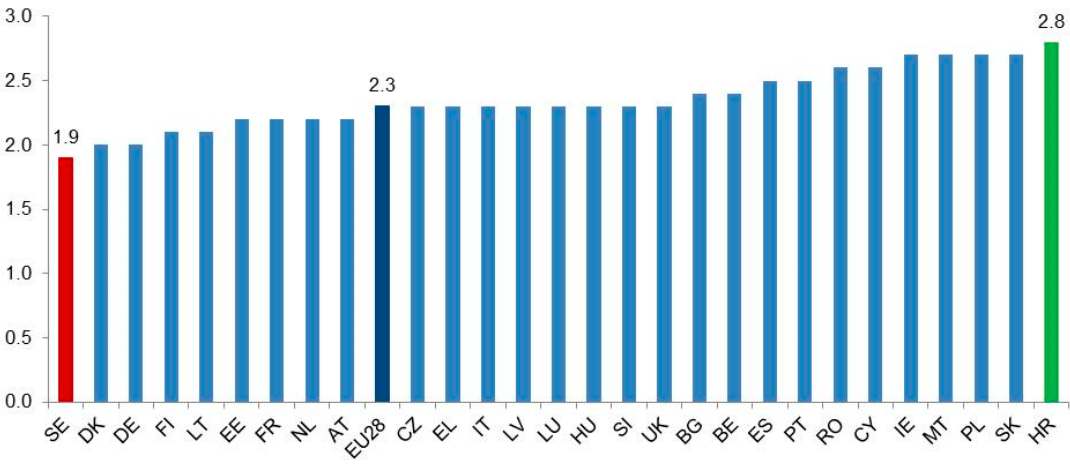
Figure 11. Average number of people per household in the EU-28 member states, 2016. Source: Eurostat.